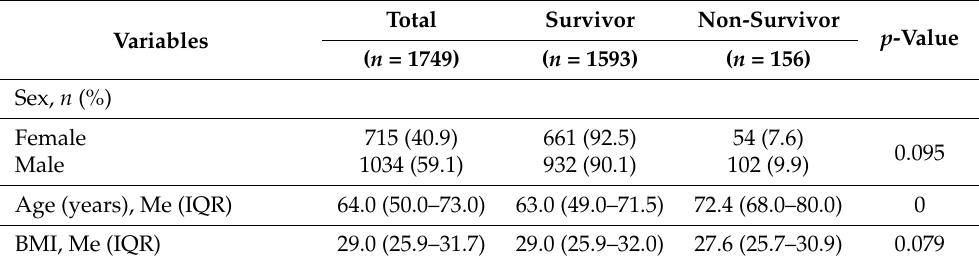
Table 1. Patient characteristics and analysis of the relationship between mortality and selected variables. Total Variables